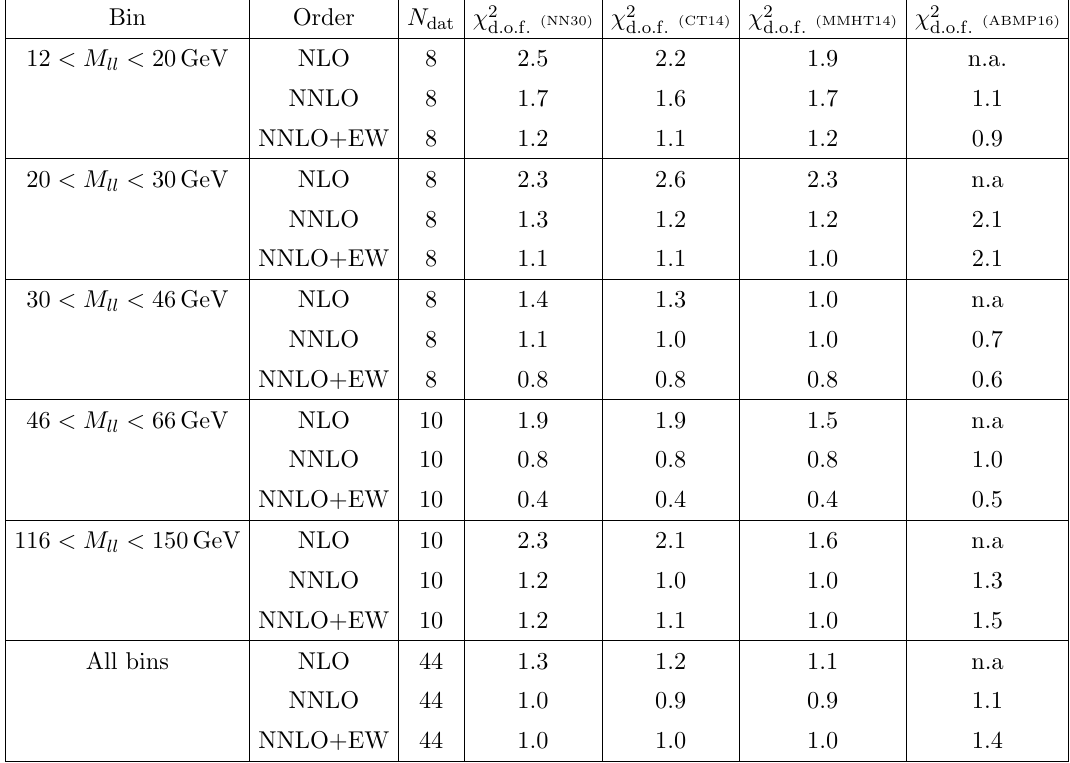
Table 2 . Same as table 1 for the ATLAS 8 TeV p Z bins before their inclusion in the (cid:12)t.